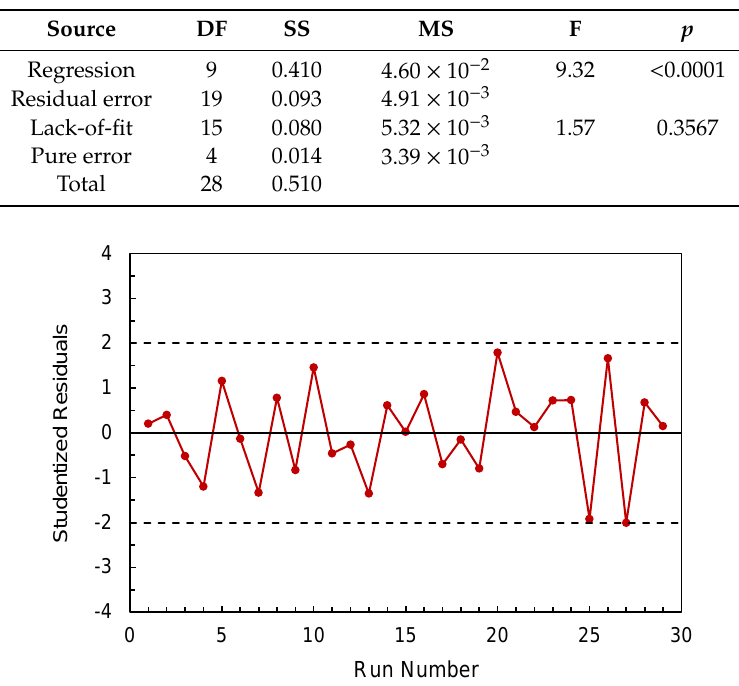
Figure 2. Studentized model residuals as a function of run number.